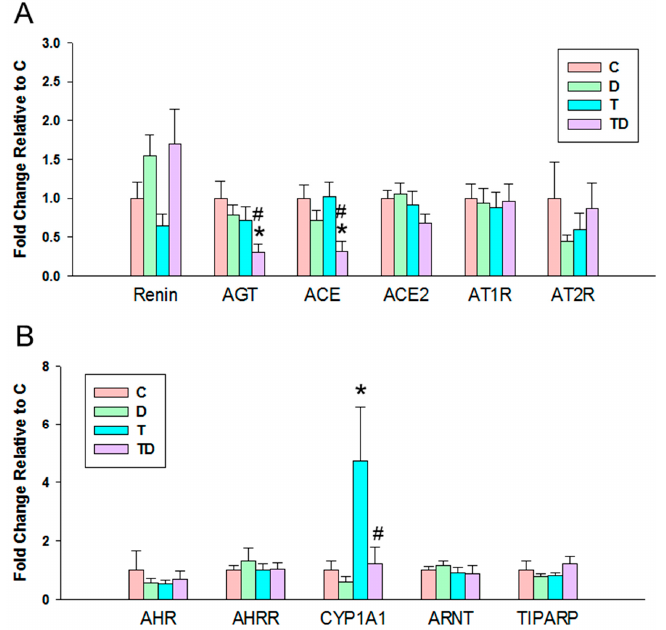
Figure 3. Effect of 3,3-Dimethyl-1-butanol (D) and 2,3,7,8-tetrachlorodibenzo-p-dioxin (T) on the mRNA expression of ( A ) renin-angiotensin system and ( B ) acryl hydrocarbon receptor (AHR) signaling pathway in offspring kidneys. AGT = angiotensinogen; ACE = angiotensin converting enzyme; ACE2 = angiotensin converting enzyme-2; AT1R= angiotensin II type 1 receptor; AT2R = angiotensin II type 2 receptor; AHR= aryl hydrocarbon receptor; AHRR = Aryl hydrocarbon receptor repressor; CYP1A1 = cytochrome P450 CYP 1A1; ARNT = Aryl hydrocarbon receptor nuclear translocator; TIPARP = TCDD-inducible poly-ADP-ribose polymerase; N = 8 per group; * p < 0.05 vs. C; # p < 0.05 vs. T. Nutrients 2021 , 13 , x FOR PEER REVIEW